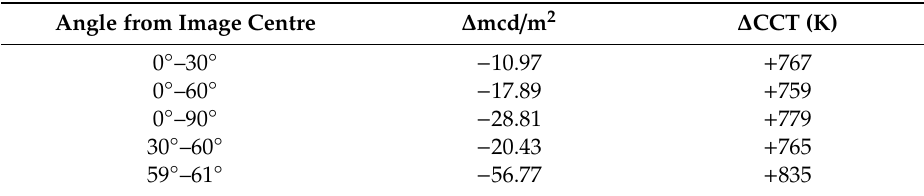
Table 1. Development of luminance [mcd / m 2 ] and colour temperature [K] values for di ff erent zenith angles as analysed from the subtraction of images as seen in Figure 19 by SQC